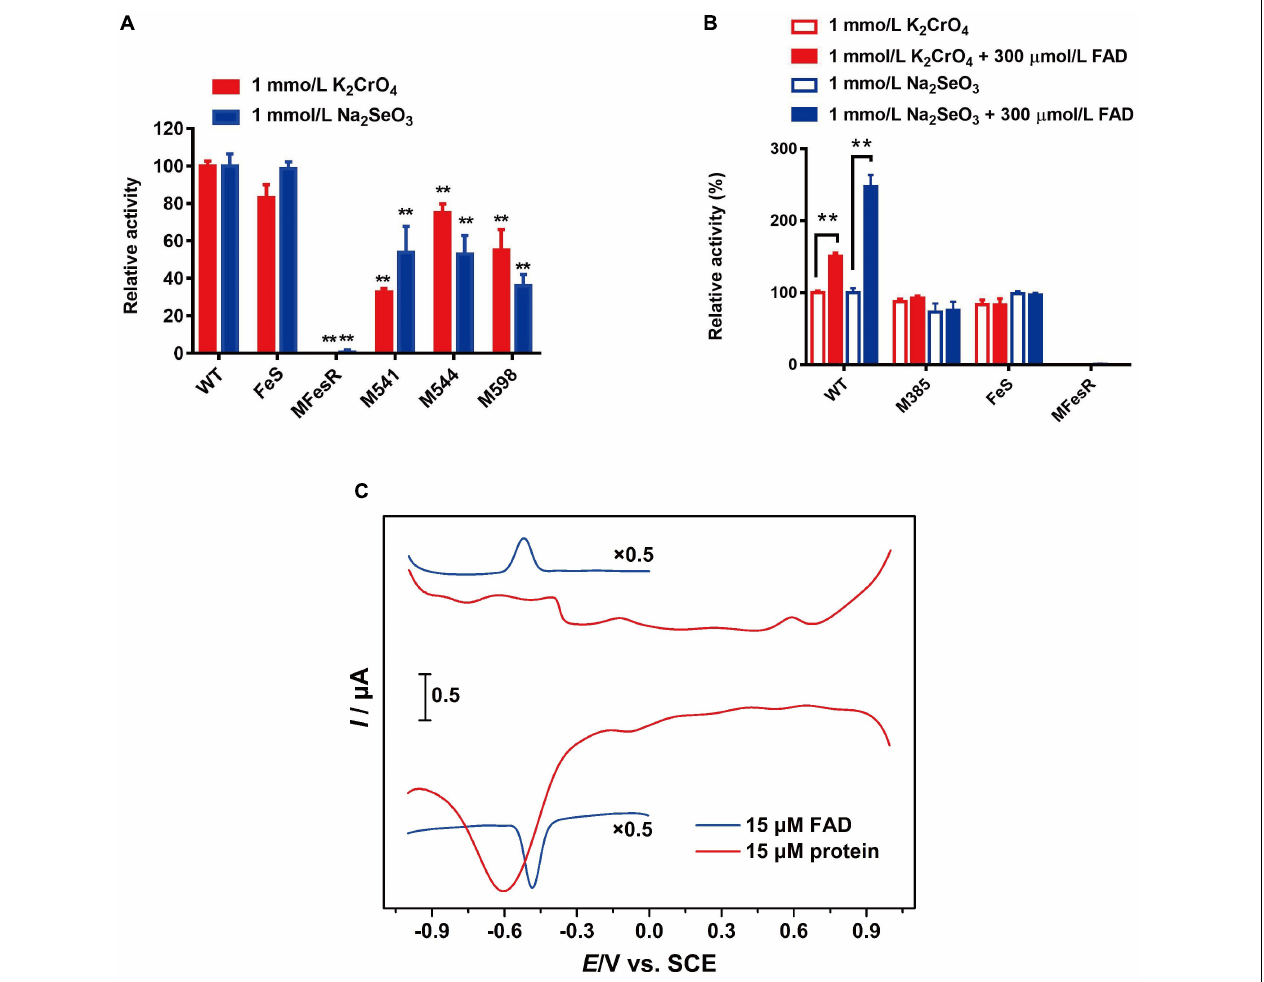
FIGURE 7 | Function of co-factors and redox potential analysis. Effects of 4Fe-4S cluster (A) and flavin adenine dinucleotide (FAD) (B) on the FesR enzymatic activity. Samples were prepared in triplicate, and the results are presented as the means ± SD. DPVs of bare GC electrodes in 50 mM Tris-HCl buffer solution (pH = 8) with 15 µ mol/L FesR or 0.1 mmol/L FAD (C) . Potential increment: 4 mV; amplitude: 50 mV; pulse width: 0.06 s; pulse period: 0.5 s. **stands for the statistically highly significant as P <